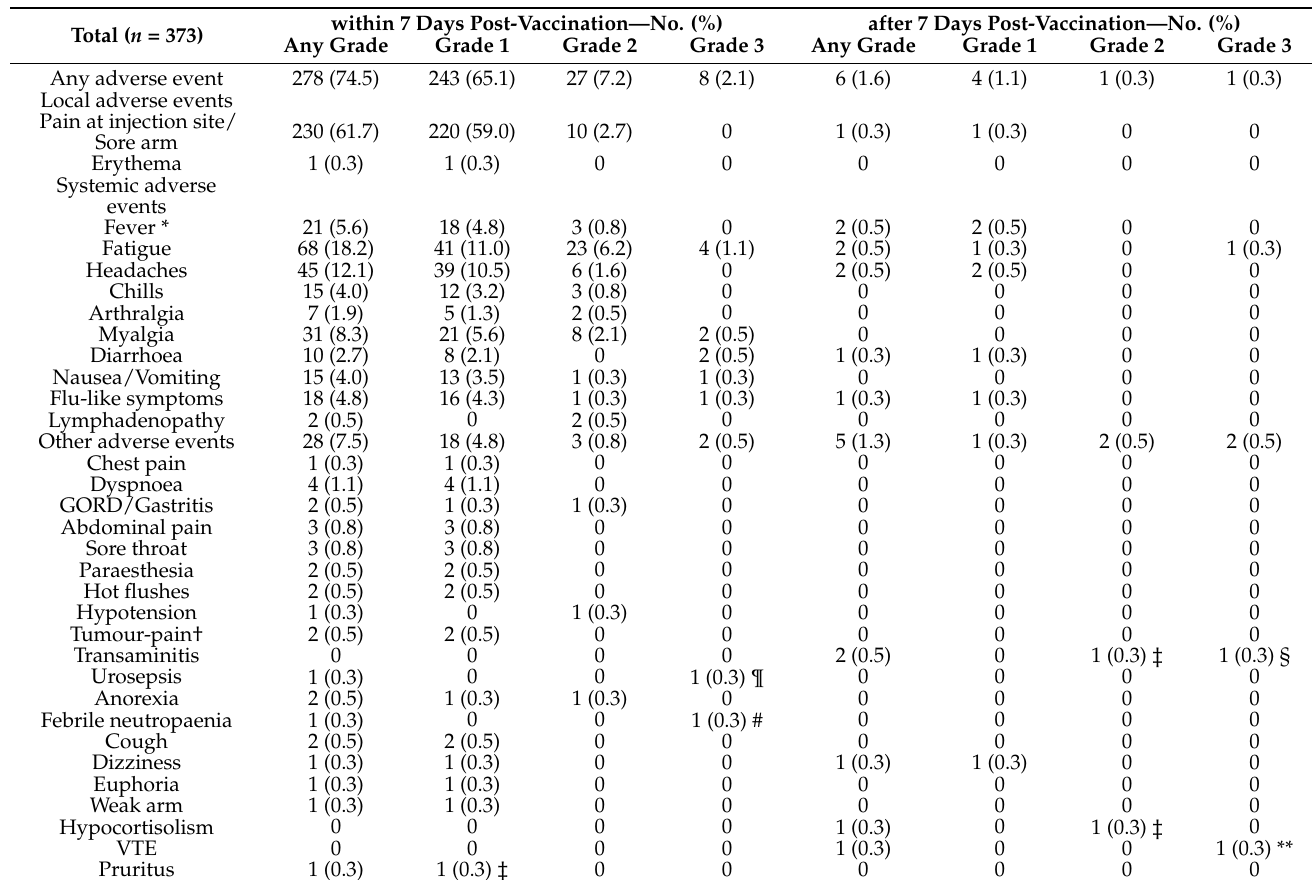
Table 4. Local and systemic adverse events reported after the first dose of the COVID-19 vaccine. within 7 Days Post-Vaccination—No. Total ( n = 373)